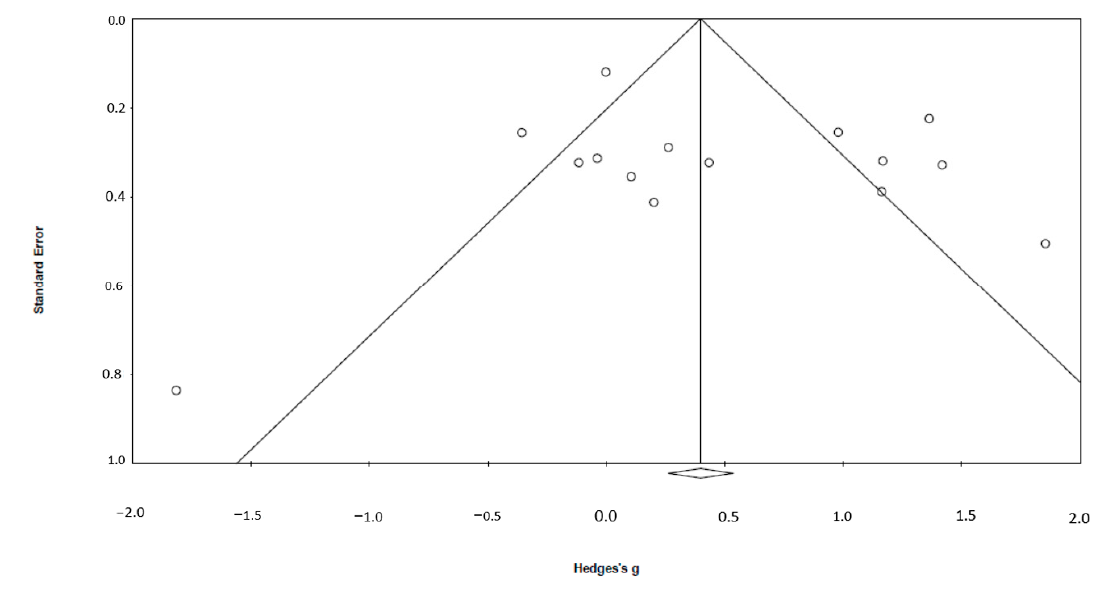
Figure 3. Funnel plot showing distribution of Hedges’ g in relation to standard error.